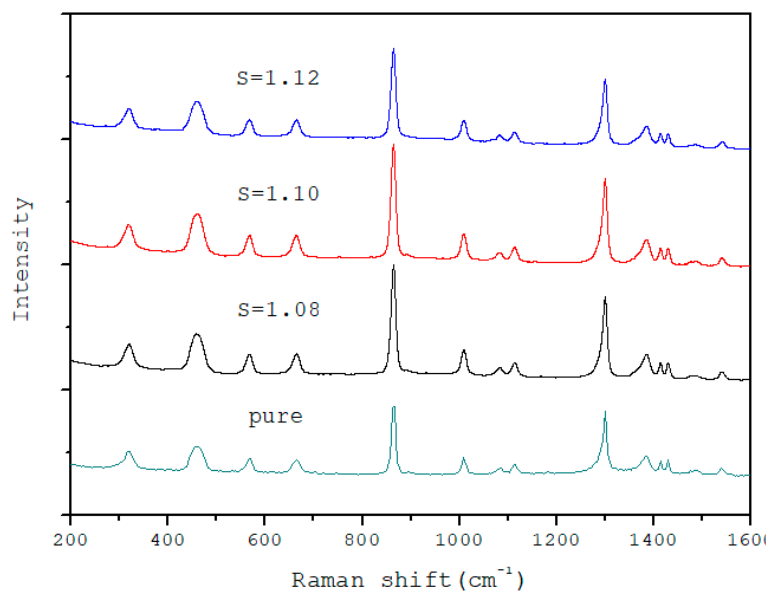
Figure 4. The Raman spectra of pure α -form crystals and product crystals obtained in the induction time experiments for various supersaturations at 303.15 K.